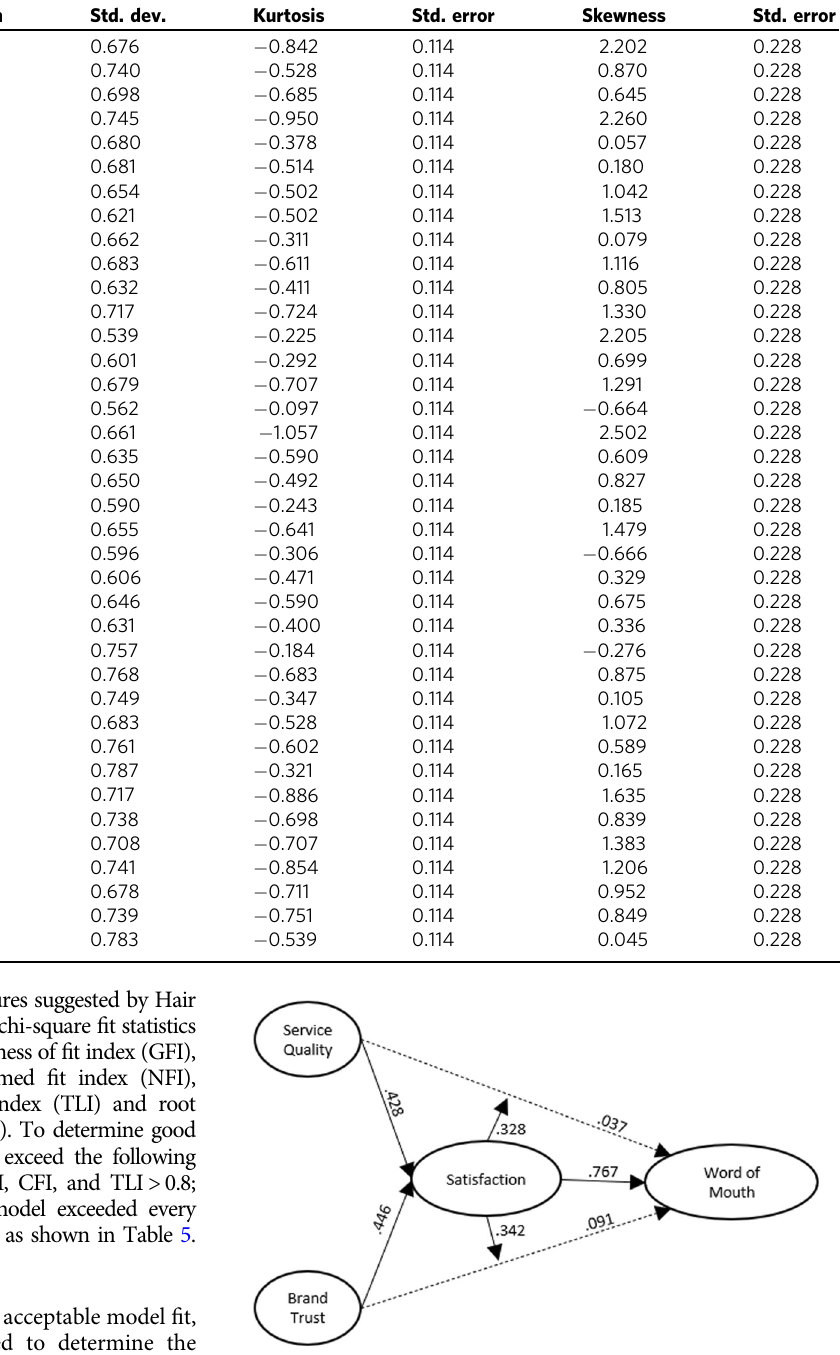
Fig. 2 Illustrated structural equation model with direct and indirect effects. Solid lines indicate p < 0.05, dashed lines indicate p >